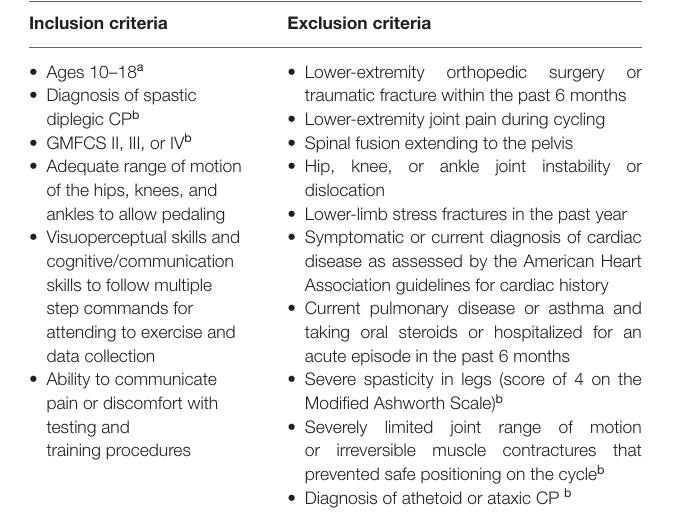
TABLE 1 | Inclusion and exclusion criteria.